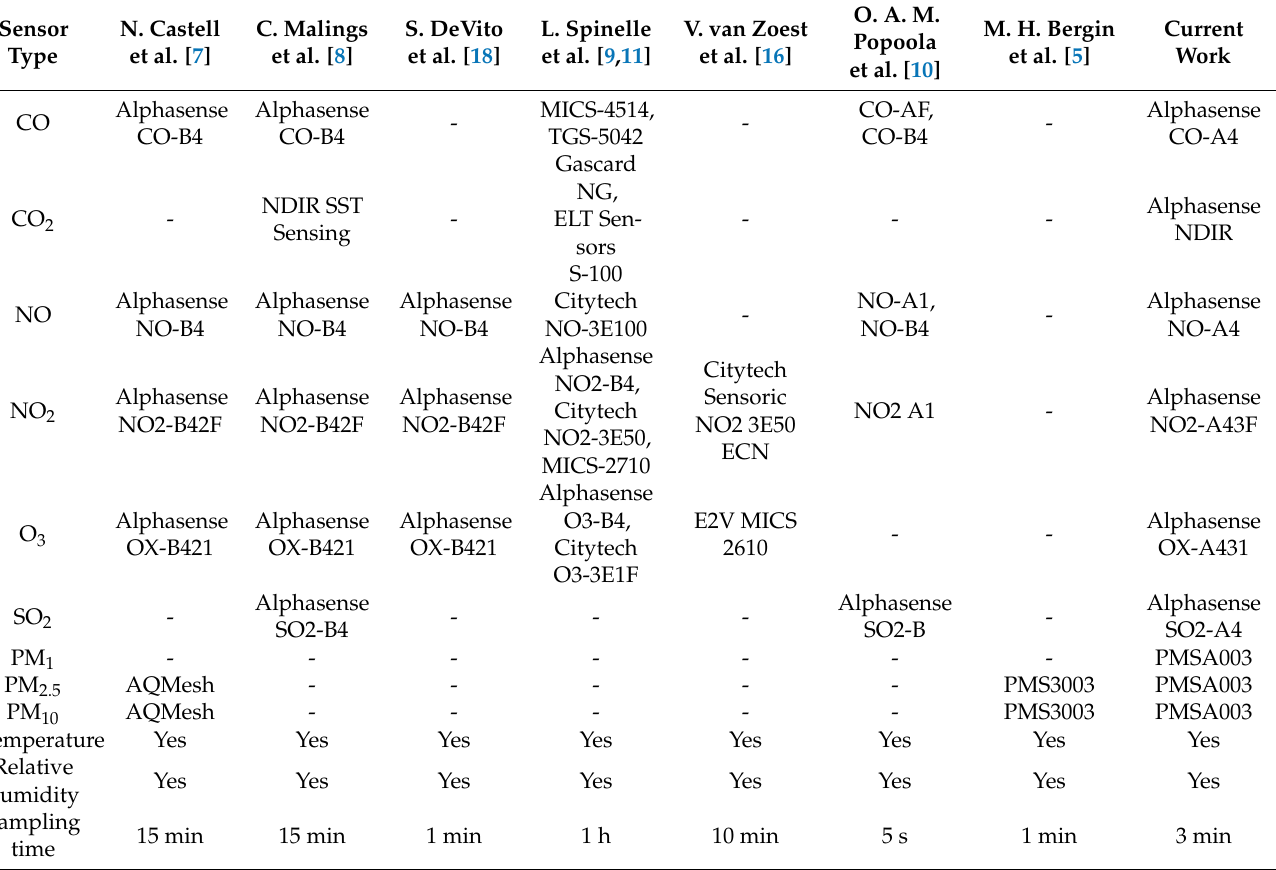
Table 2. Comparison of the device under test and literature